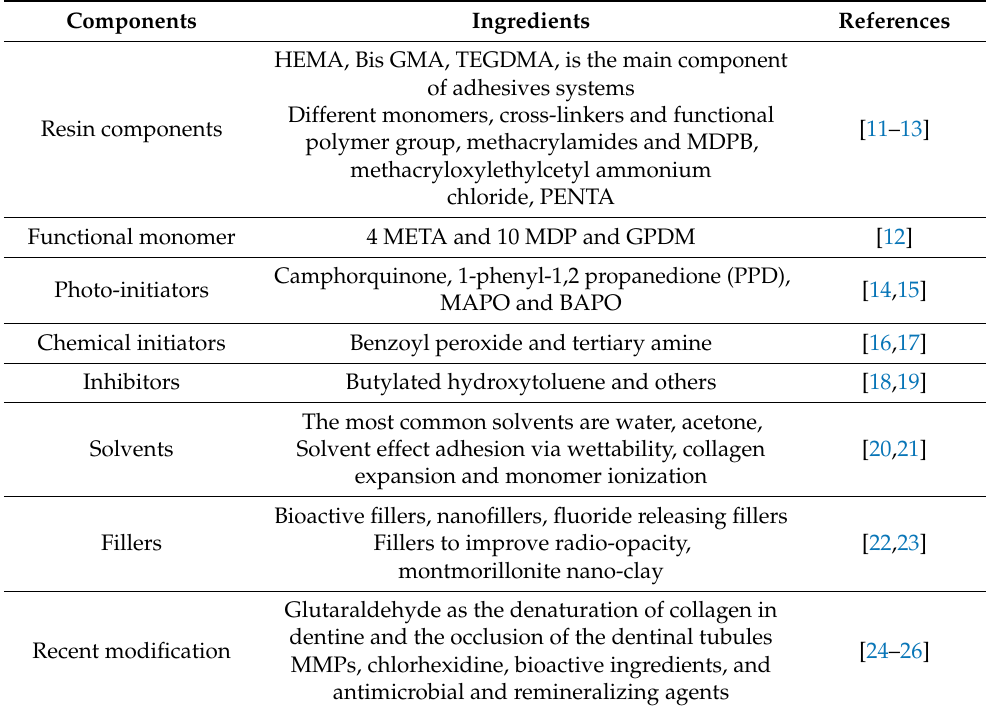
Table 1. A description of the components of bonding agents. Components